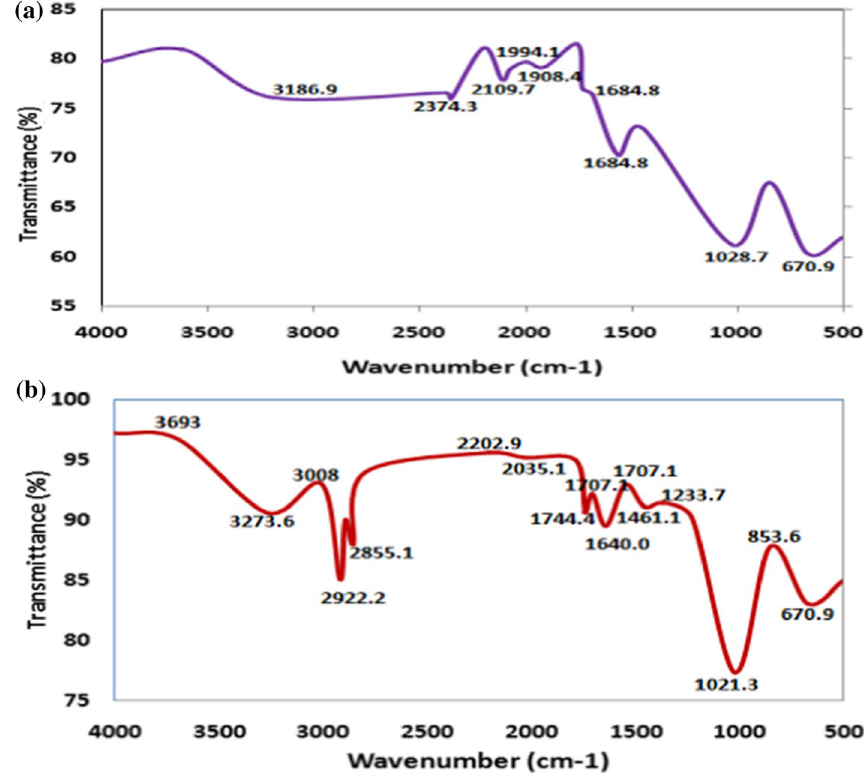
Fig. 3 FTIR spectrum: a raw rice husk; b